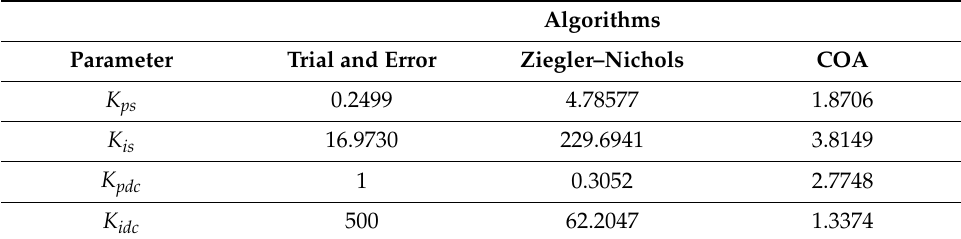
Table 1. Optimized PI controller gains.